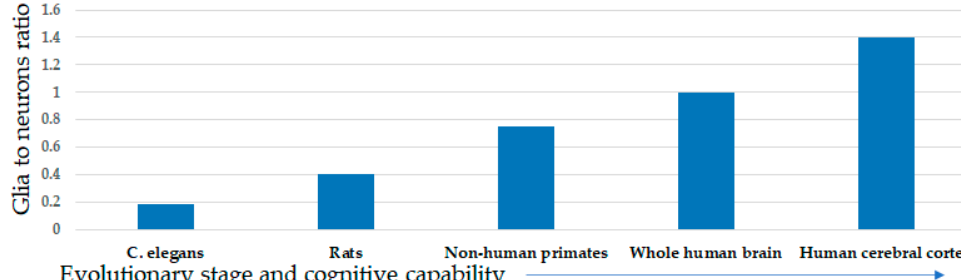
Figure 2. Glia-to-neurons ratio, according to the species’ evolutionary stage. The glia-to-neuron ratio increases as the species’ evolutionary stage progresses and its cognitive capability increases.